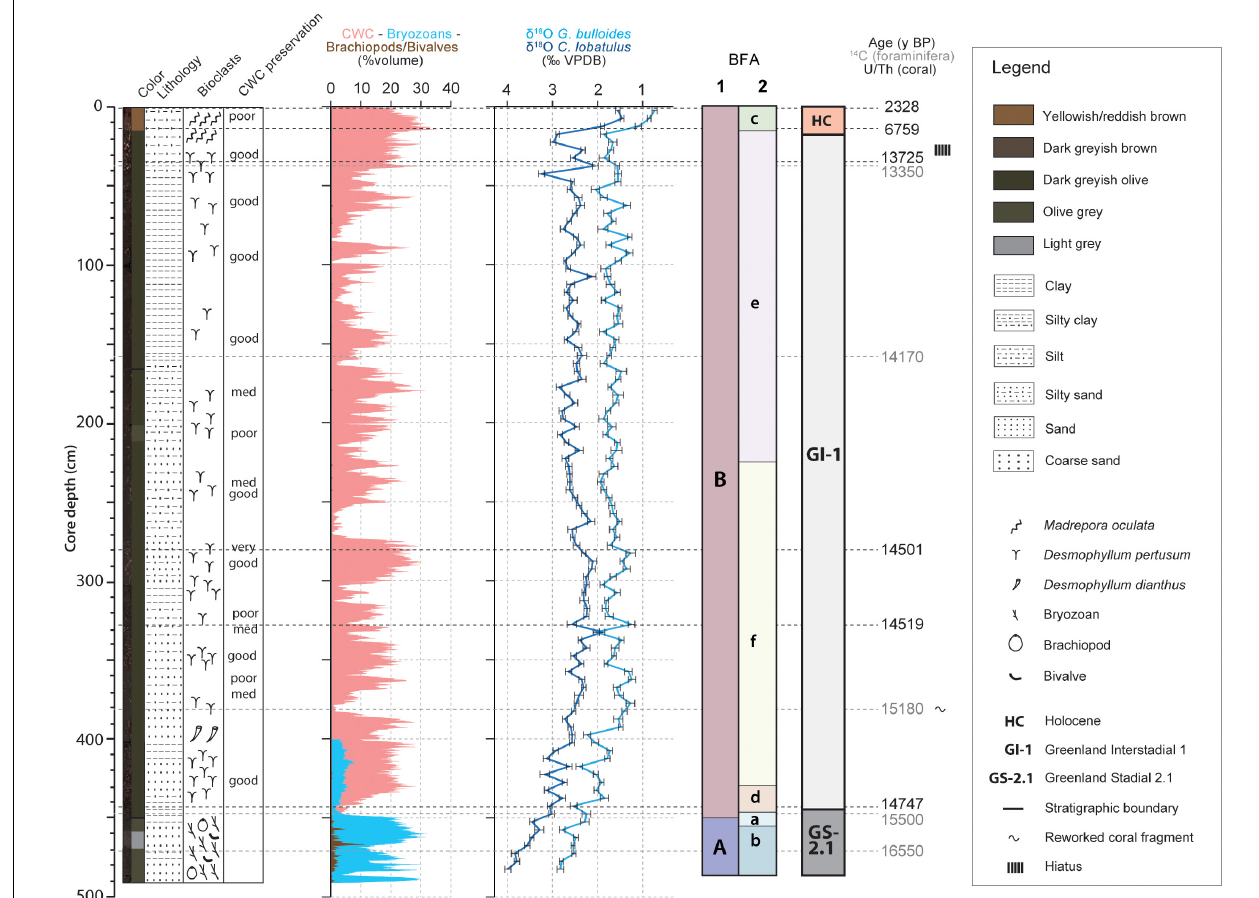
FIGURE 2 | Stratigraphy, core description and macrofaunal content of core MD13-3455G. The core descriptions and macrofaunal content were previously reported by Feenstra (2020). The stratigraphy is constructed by combining the G. bulloides planktonic (light blue curve) and C. lobatulus benthic (dark blue curve) δ 18